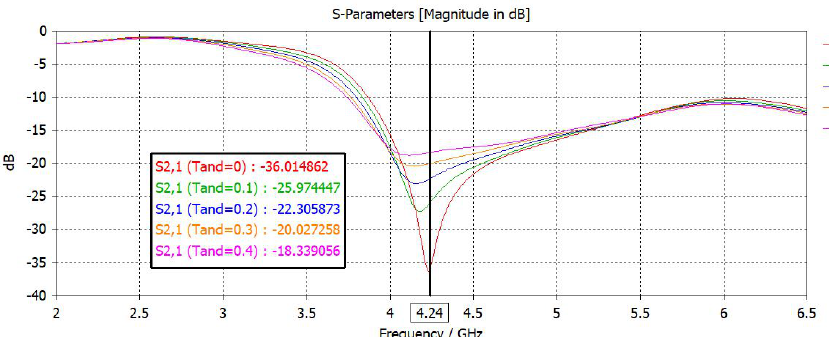
Figure 9. Analysis of loss tangent (Tand) variation on the resonance